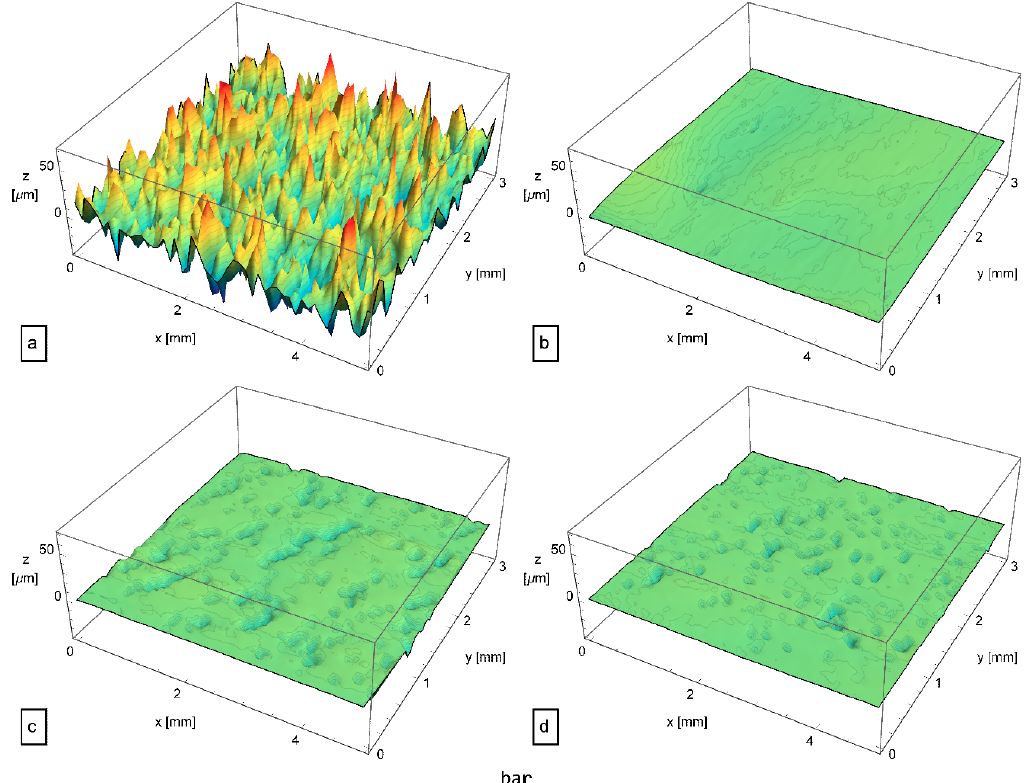
Figure 17. Three-dimensional (3D) map of feature A before finishing (a), feature A after 48 h (b), feature B after 48 h ( c ), and feature E after 48 h (d).